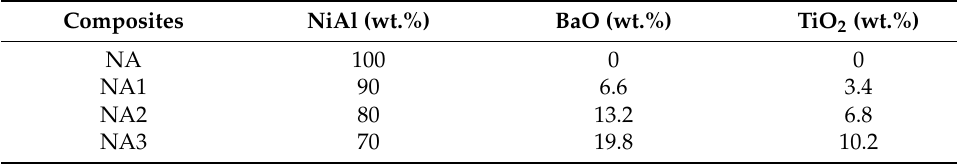
Table 1. Composite composition.